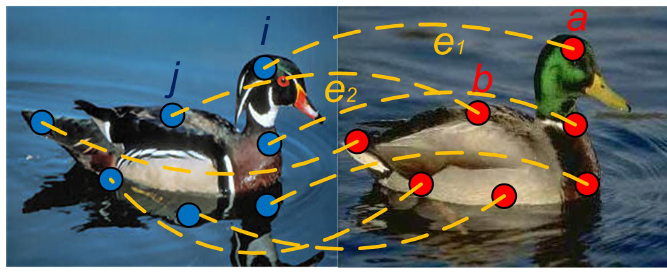
Figure 1. Feature point correspondence